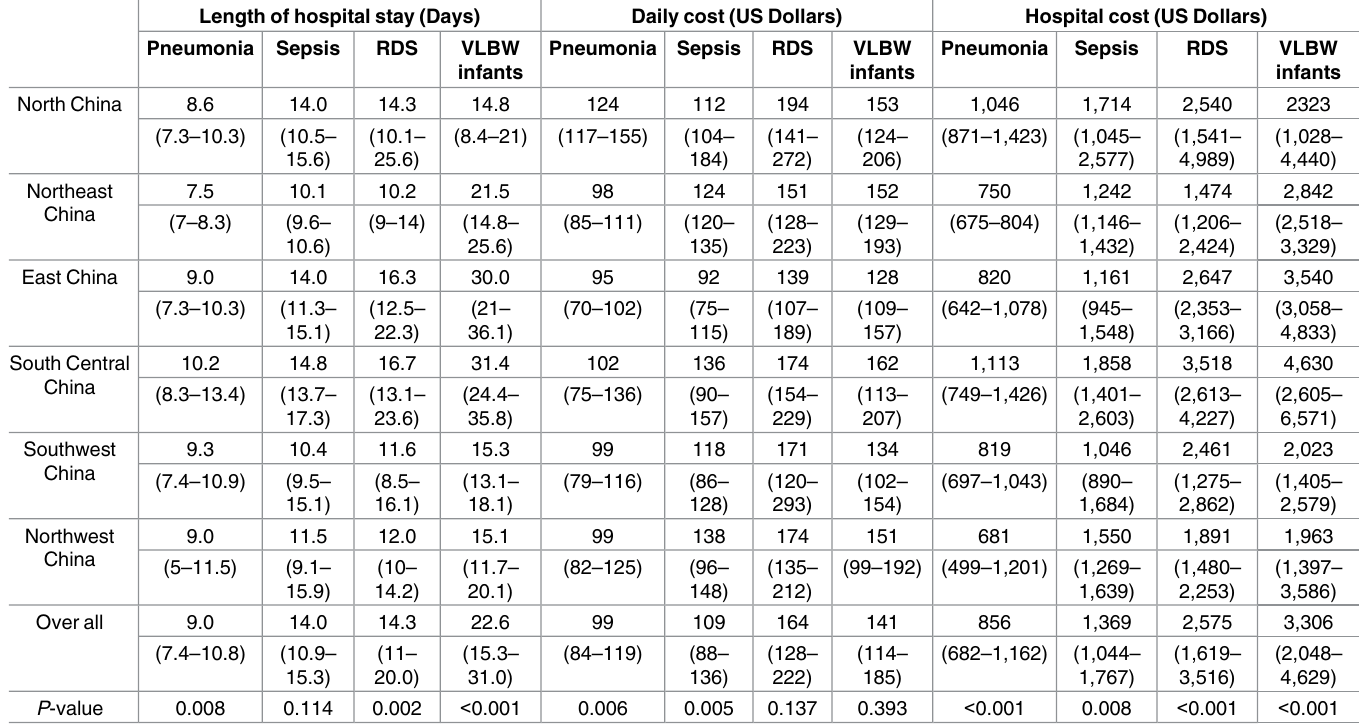
Table 2. Diseaseexpenditure of a single hospital stay for common newborn diseasesduring 2008–2010. Length of hospital stay